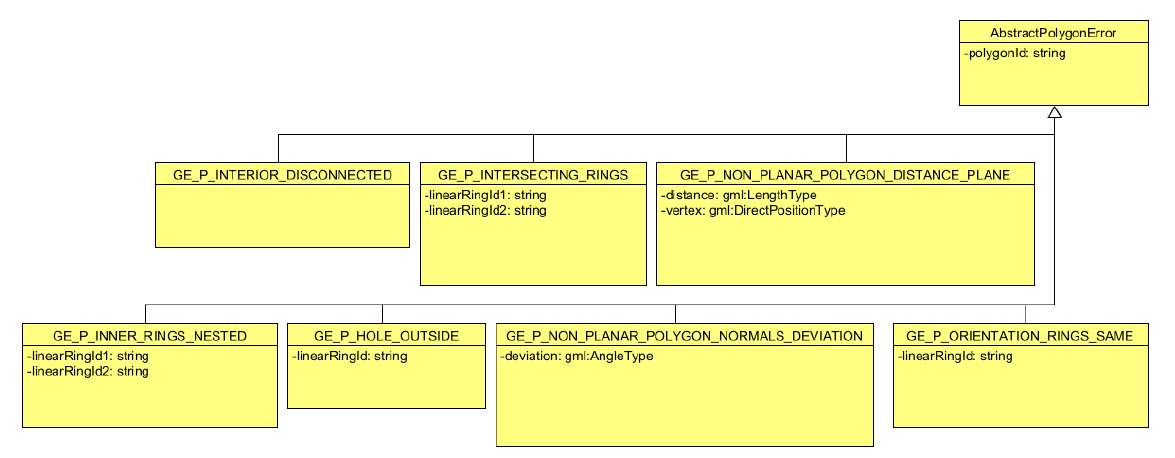
Figure 5. Ring Error Datastructures